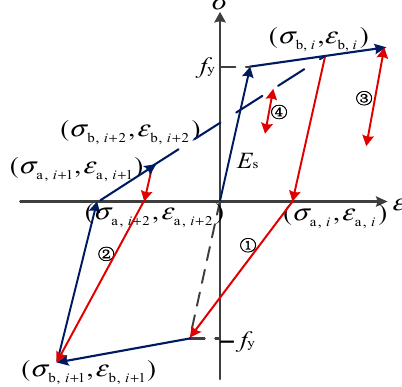
Figure 2. The cyclic constitutive model of steel.